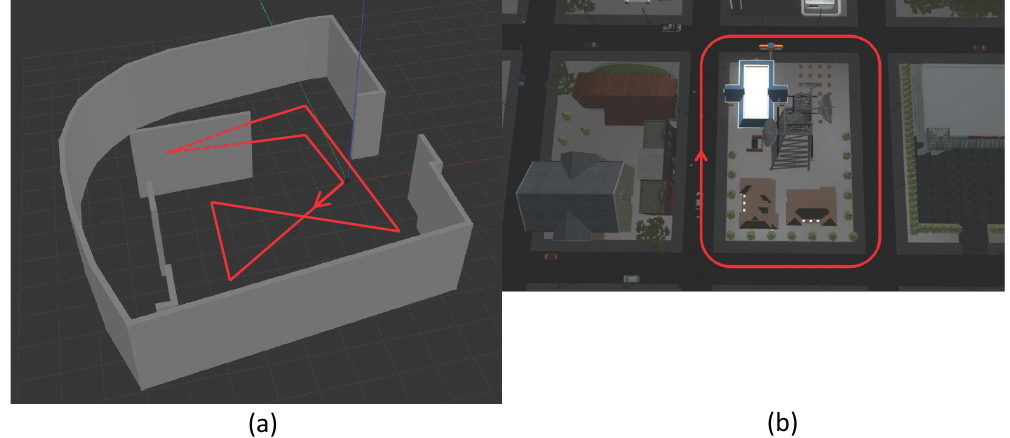
Figure 5. Overview of the setup of the simulation environments, namely the test factory ( a ) and the car environment ( b